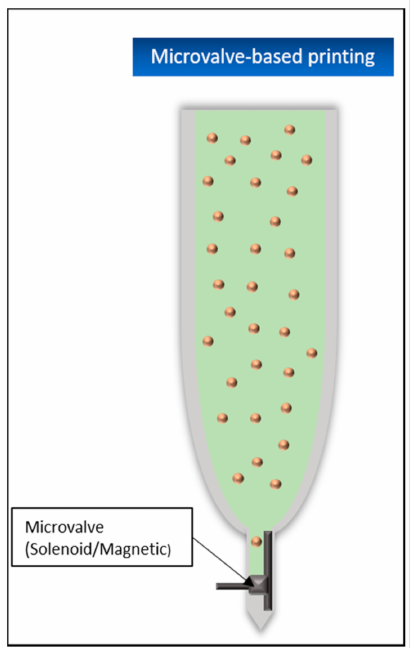
Figure 10. Schematic representation of the microvalve-based printing. The dispensing of the drop- shaped material is controlled by the combination of a magnetized coil and a small plug on the nozzle